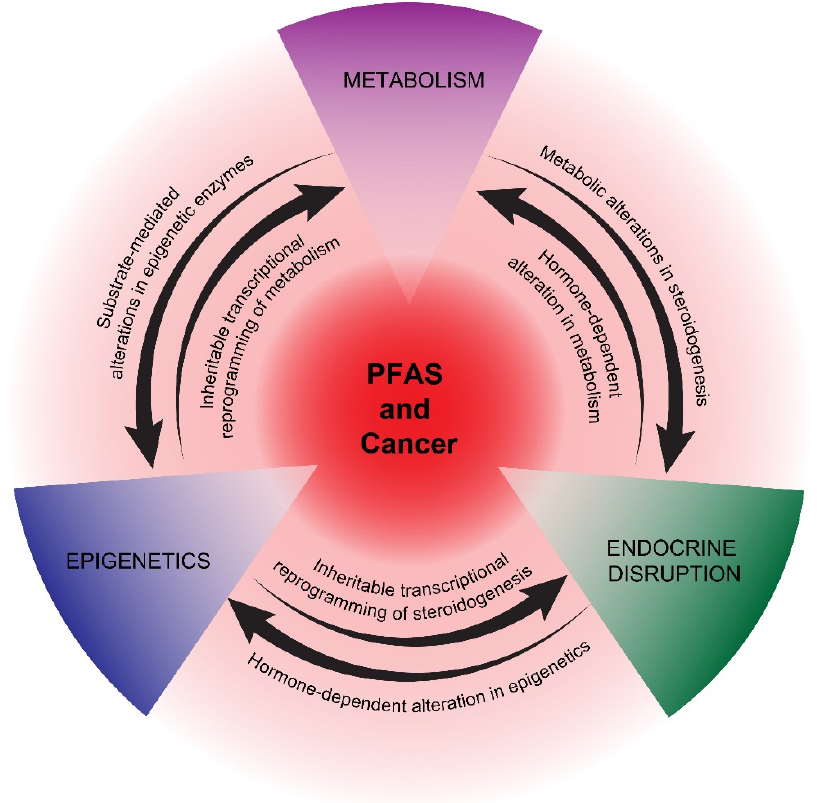
Figure 2. Proposed mechanisms of potential PFAS cancer promotion. PPAR-dependent and -independent reprogramming of metabolism, epigenetics, and endocrine disruption are represented as interconnecting, mutually reinforcing pathways of potential PFAS tumor promotion. The precise details of how PFAS influences these pathways are still uncertain, as is the impact of other proposed PFAS mechanisms, including immunosuppression and oxidative stress.